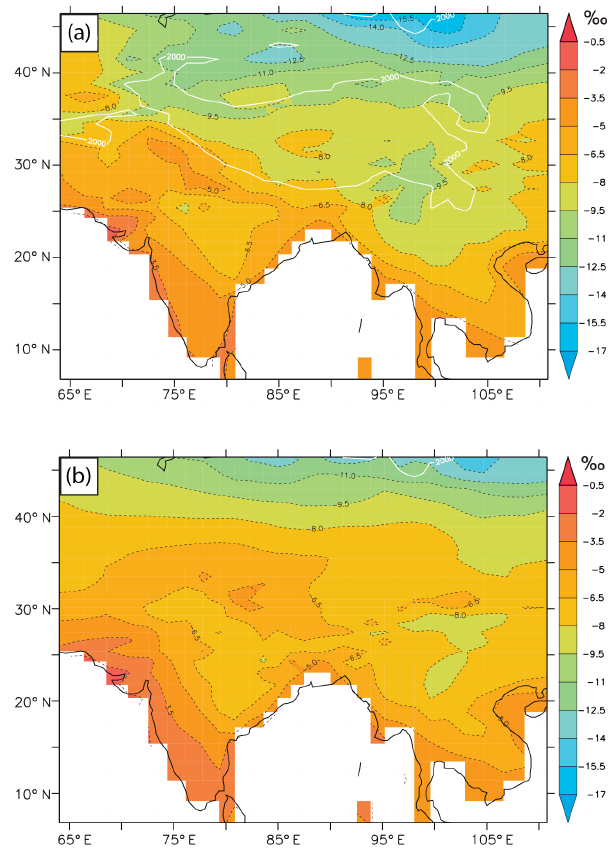
Figure 9. Annual mean δ 18 O in precipitation simulated by LMDZ- iso for (a) INT case and (b) LOW